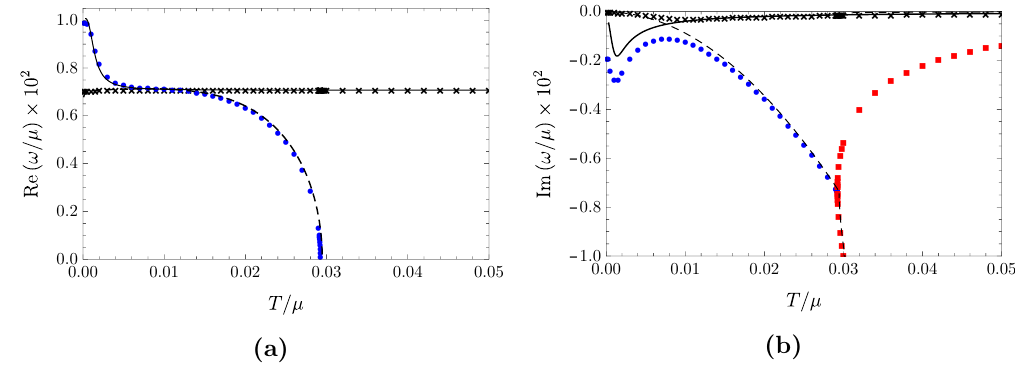
Figure 4. The same data as (cid:12)gure 3b but with separate plots for (a) Re ( !=(cid:22) ) and (b) Im ( !=(cid:22) ), each enhanced by 10 2 for clarity, as functions of T=(cid:22) . The color and shape coding are the same as (cid:12)gure 3b. The dashed black lines denotes the probe limit HZS dispersion in eqs. (3.1) and (3.2) while the solid black line denotes the hydrodynamic sound dispersion. At low T=(cid:22) the black crosses follow the black dashed line, identifying those poles as HZS, and as T=(cid:22) increases they crossover to the solid black line, indicating they have become hydrodynamic sound. The upper branch of red squares eventually approaches the probe limit charge di(cid:11)usion dispersion in eqs. (3.4) and (3.5) (not shown), identifying that as the di(cid:11)usion